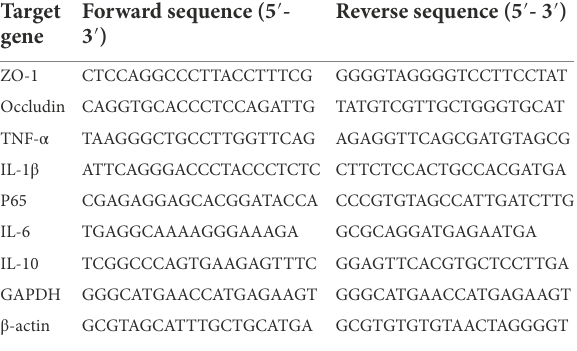
TABLE 2 The nucleotide sequences of